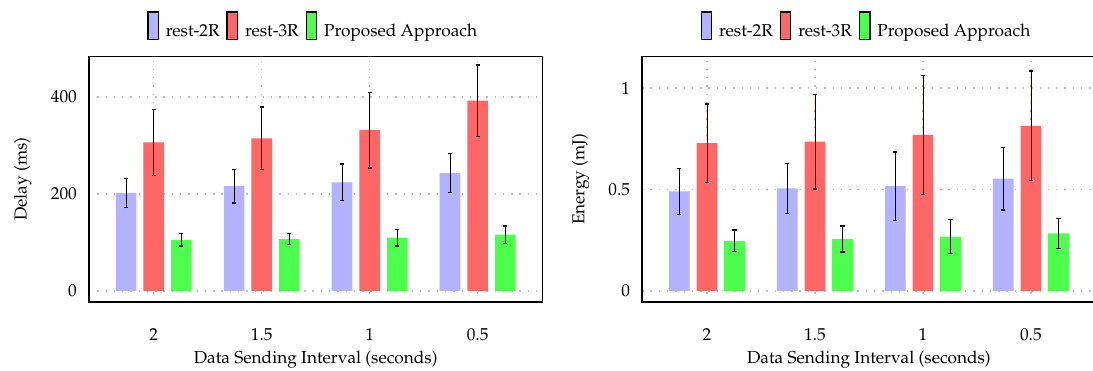
Figure 10. Scenario 1: Average delay and energy consumption comparison of proposed approach against REST based communication to two and three data